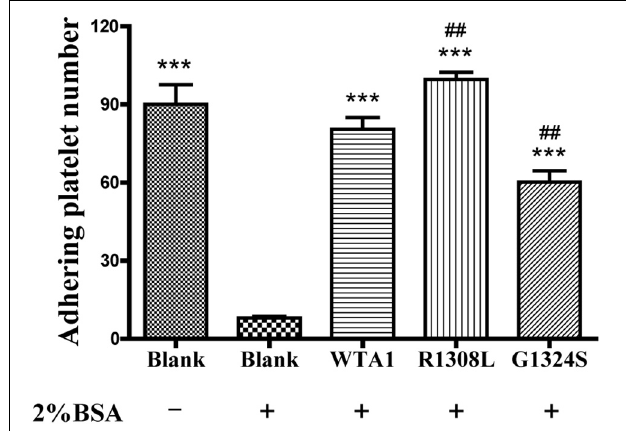
FIGURE 1 | Specificity of platelet binding to substrates with or without VWF-A1 and its two mutants (R1308L and G1324S). The firmly adhering platelets on substrates with various treatments were numbered after perfusing phosphate-buffered saline over the substrates in a parallel plate flow chamber under a fluid shear stress of 1 dyn/cm 2 for 5 min. The data represent the mean ± SEM from three independent experiments. Statistical significance was analyzed by one-way ANOVA for multiple comparisons with Bonferroni post hoc test; *** p < 0.001 compared with the blank group (treaded with 2% bovine serum albumin); ## p < 0.01 compared with the WTA1